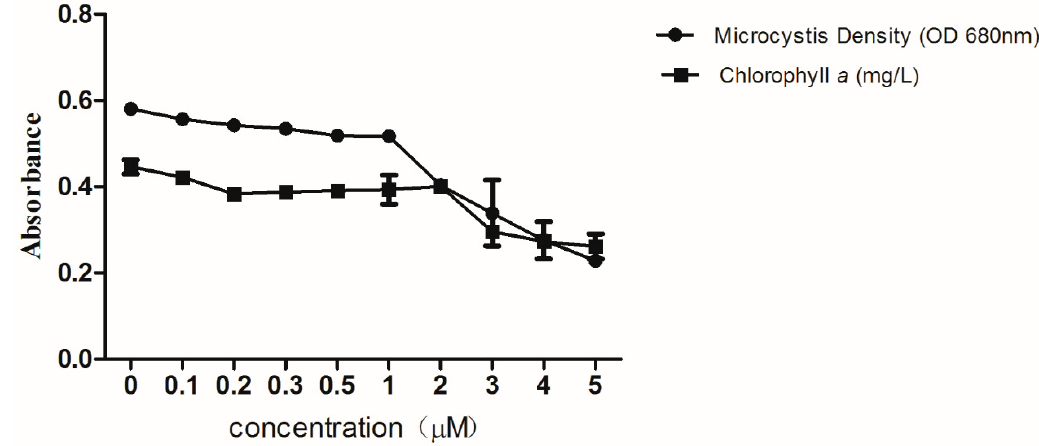
Figure 1. The algicidal ability of copper. Exponentially growing cells of M. aeruginosa PCC 7806 were diluted to OD 680 nm at 0.58 and cultured in a BG11-Cu medium supplemented with the copper concentration (0, 0.1, 0.2, 0.3, 1, 2, 3, 4 and 5 µ M) for 4 days. The experiments were conducted in triplicates and the average with the standard deviation is plotted. * represents significance at p < 0.05 between the copper-treated groups and the control group.